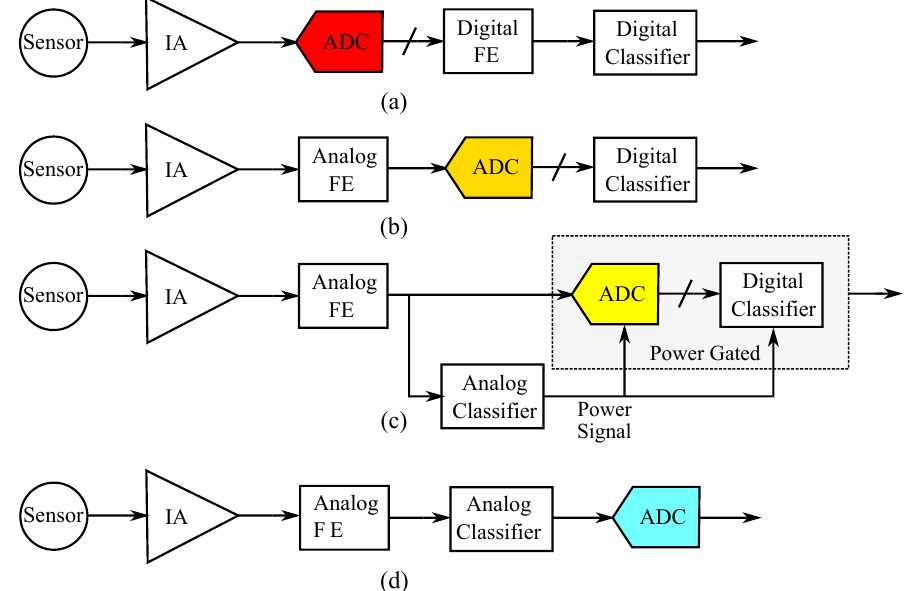
Figure 1. Different architectures for a classification system. ( a ) All digital inference; only the sensor related circuitry is analog. ( b ) The analog feature extractor replaces the digital one. ( c ) The analog front-end is used as a wake-up circuit in order to power up/down the digital back-end. ( d ) A pure analog approach. From ( a – d ), the power requirements of the ADC are